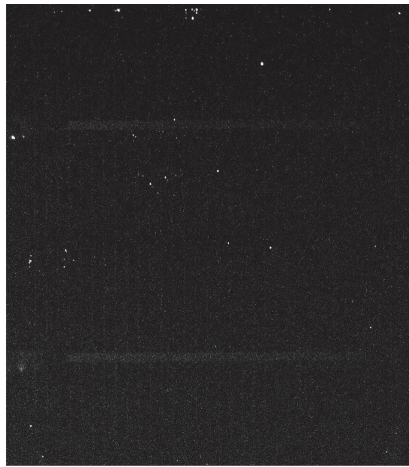
Figure 7: Microplasma method-scanning time 20 s, voltage 4.0 V, current 0.15 A, sample no. 3150-15.